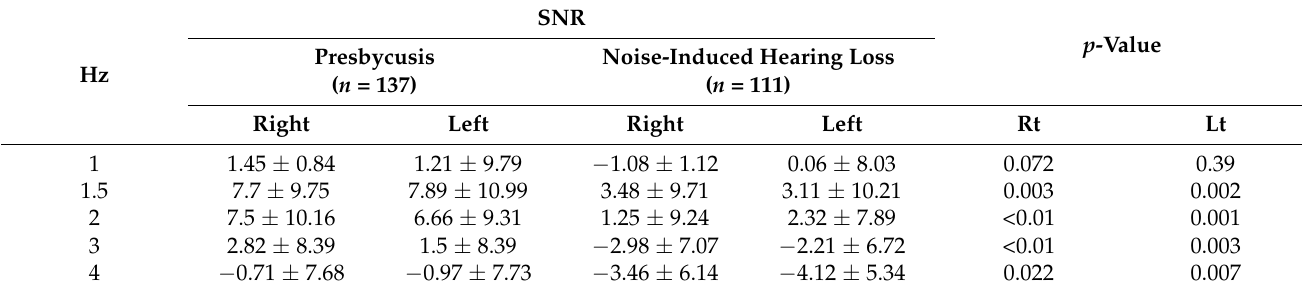
Table 5. TEOAE results showing signal-to-noise ratios in each ear of tinnitus patients with presbycusis and noise-induced hearing